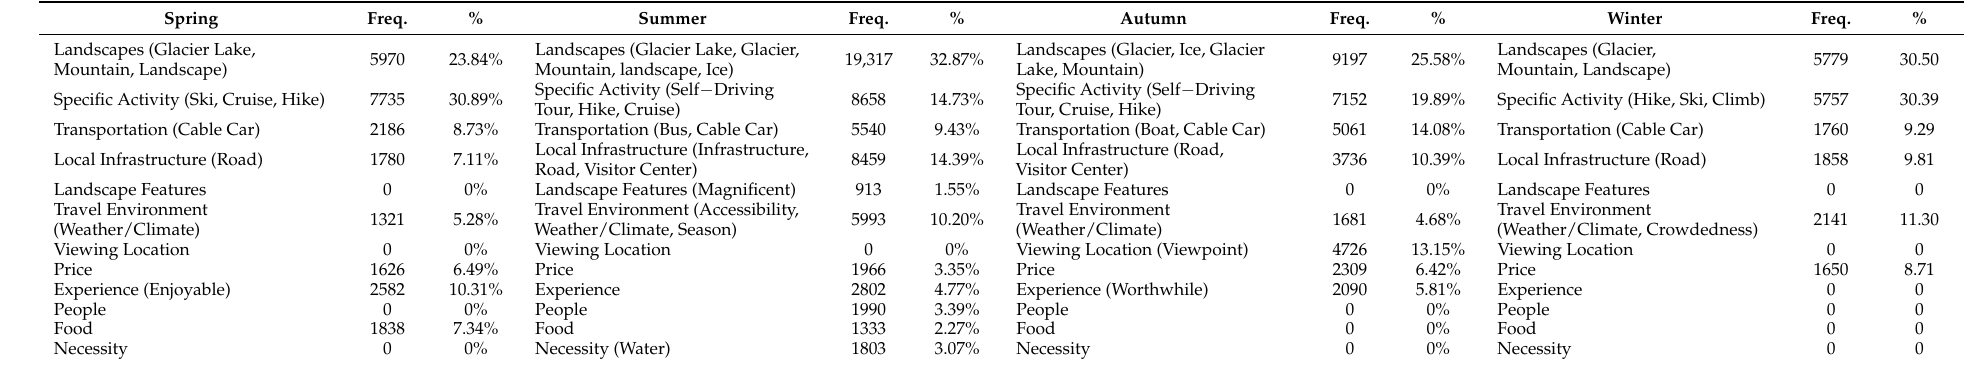
Table A3. Four seasons image statistics of glacier tourist